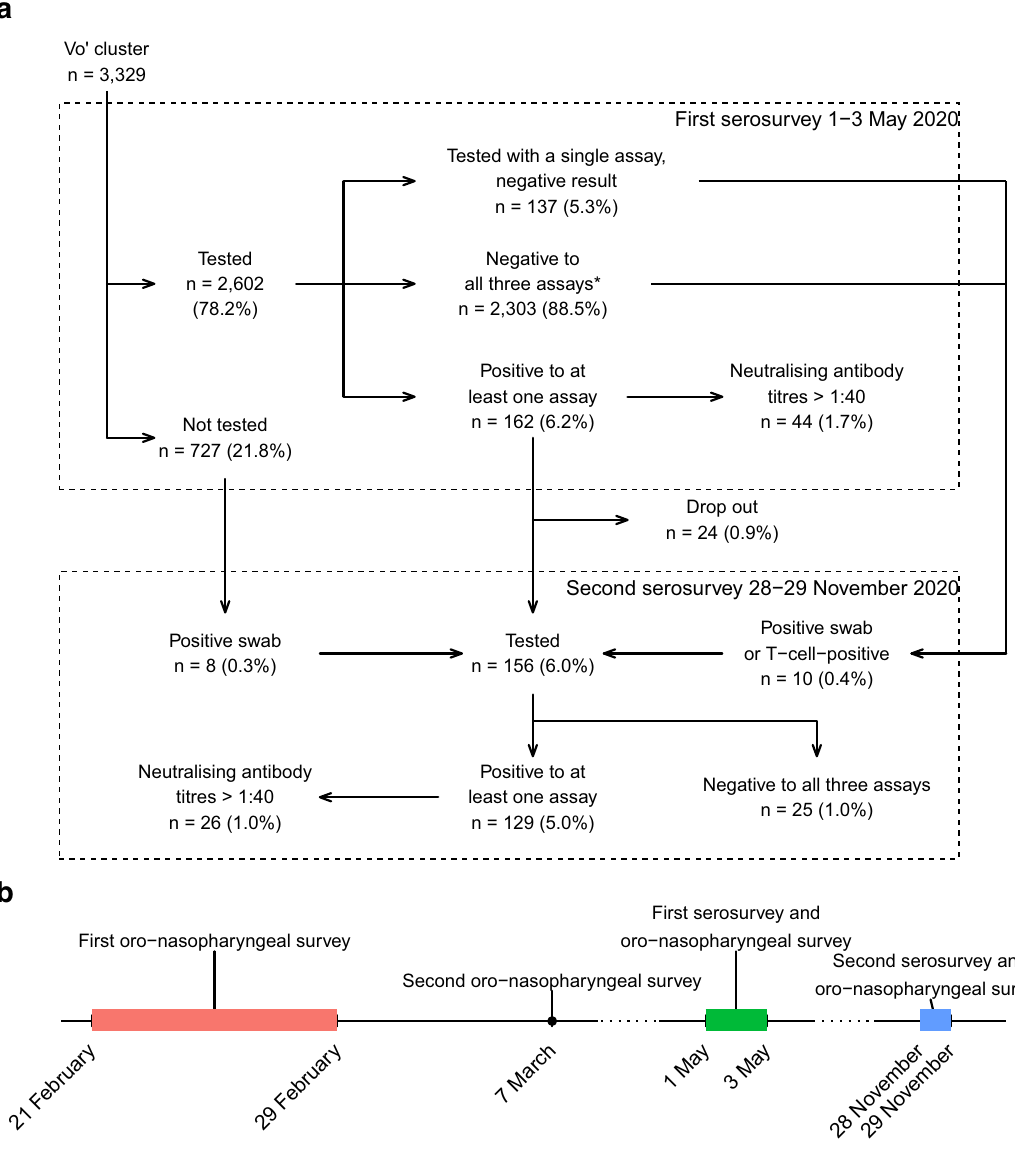
Fig. 1 Study description. a Flow chart illustrating the study design and the strati fi cation according to test results rates on the occasion of the serosurveys conducted in Vo ’ on 1 – 3 May 2020 and 28 – 29 November 2020. b Timeline of the surveys conducted in the study area since the start of the SARS-CoV-2 epidemic in Vo ’ . Table 1 Commercial assays employed in the study to identify IgG